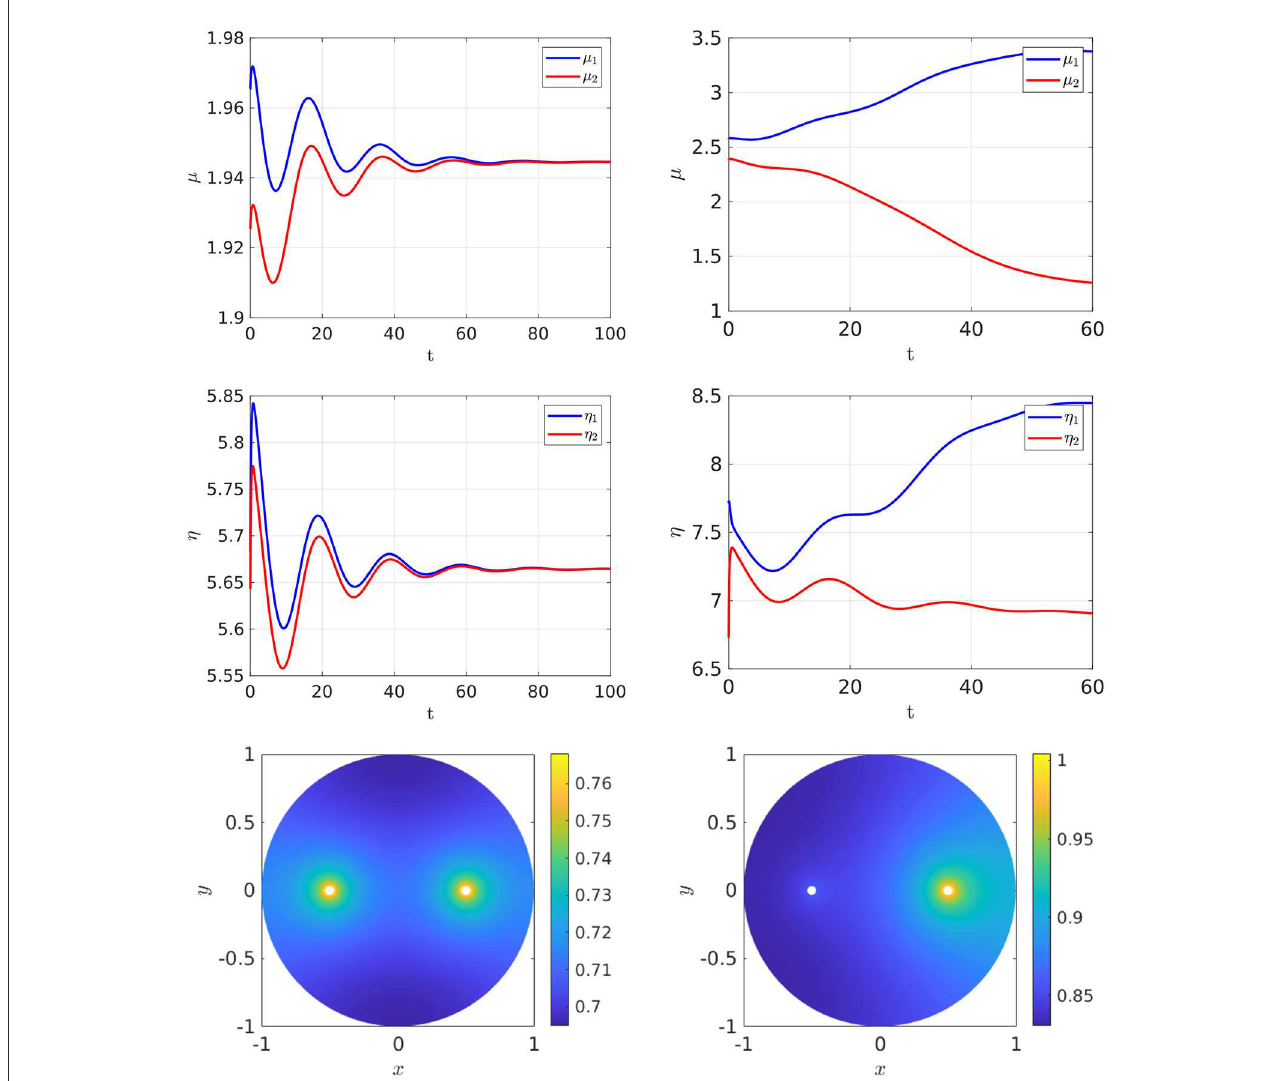
FIGURE4 Full numerical PDE simulation results of Equation (2.3) with FlexPDE [50] for GM kinetics Equation (4.3). The bottom panels show the concentration of u . Left: convergence to the symmetric branch for ρ branch. Right: convergence to the asymmetric branch selected by the eigenperturbation direction q 2 symmetric branch. Parameters: D u